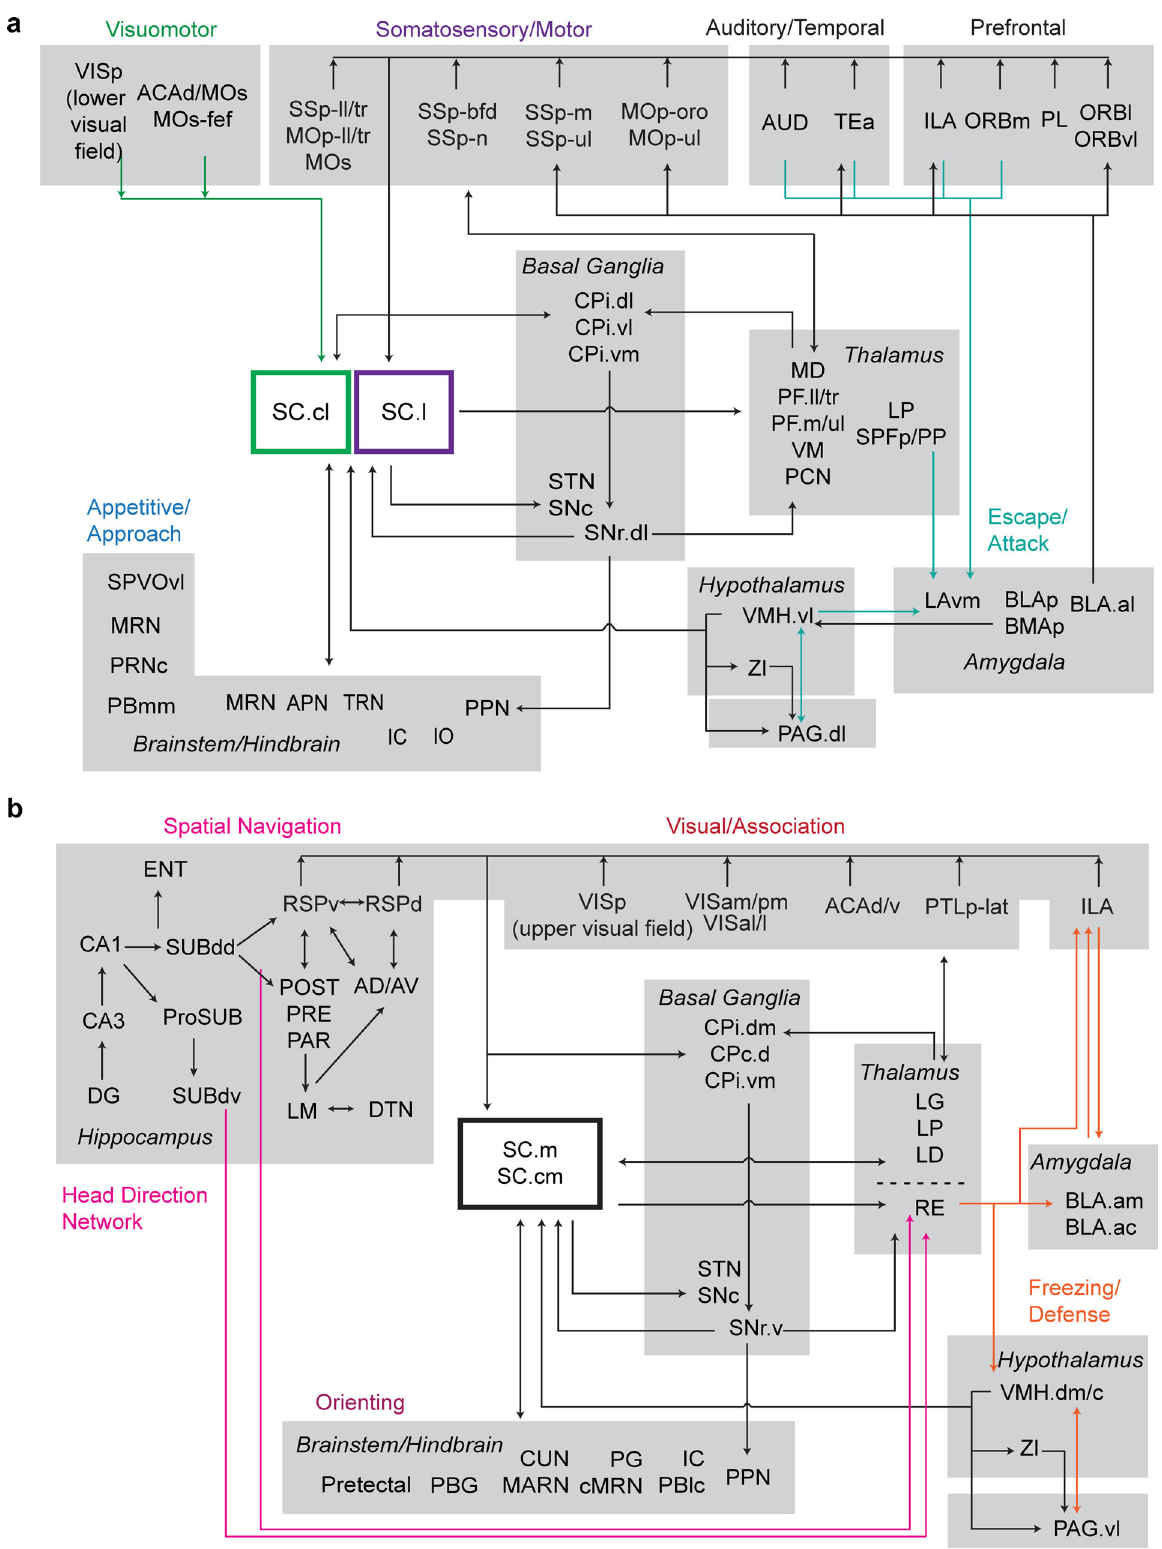
behaviors . As described, RSP, PTLp-lat, and VIS